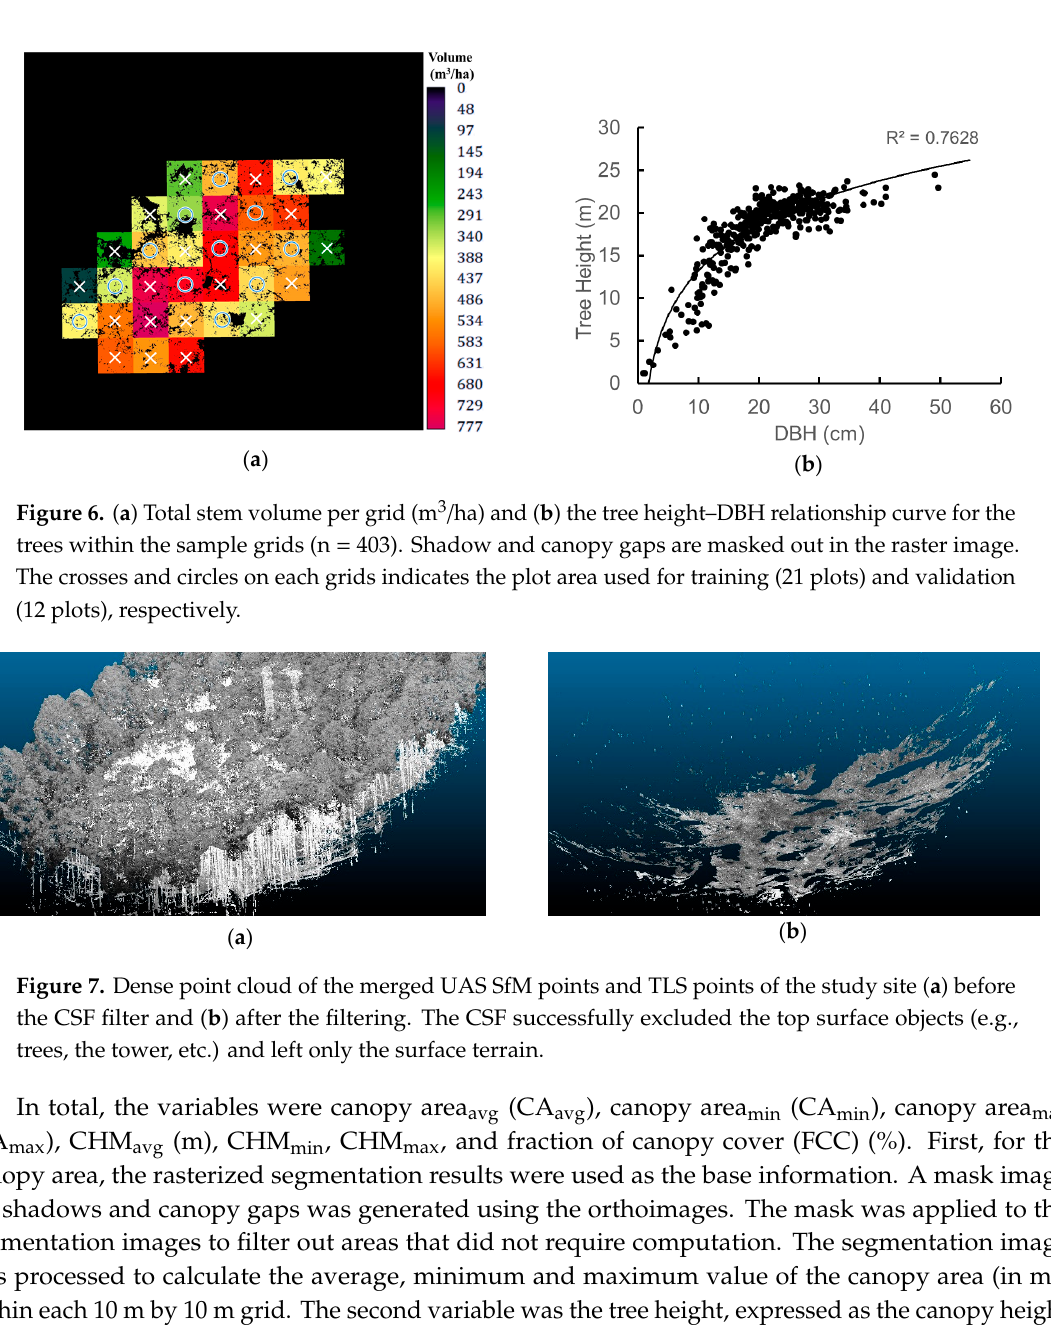
( b ) Figure 5. ( a ) Merged TLS scans of the study site, and ( b ) example of the extracted sample area with the 10 by 10 m grid size. Each individual tree was measured to compute tree height and diameter at breast height (DBH) within the grids. 3.5. Non-Destructive Biophysical Parameter Retrieval for Ground Truth The combined TLS point cloud was further used for measuring the forest’s biophysical parameters. Each of the plots was examined, and the tree height and the DBH were measured using the measuring tool in the RealWorks software. Tree parameters were recorded within each 10 m grid. The measured DBH and tree height data were converted into stem volume data using the Yamamoto equation [50] or the Schumacher and Hall equation [51]: log𝑉 = a (cid:3397) b (cid:3400) log𝐷 (cid:3397) c (cid:3400) log𝐻 (2) where V is the stem volume (m 3 ), D is DBH (cm) and H is tree height (m). The parameters a, b and c are coefficients, and for the cypress trees in this region, their values are as follows: a = − 4.31101,